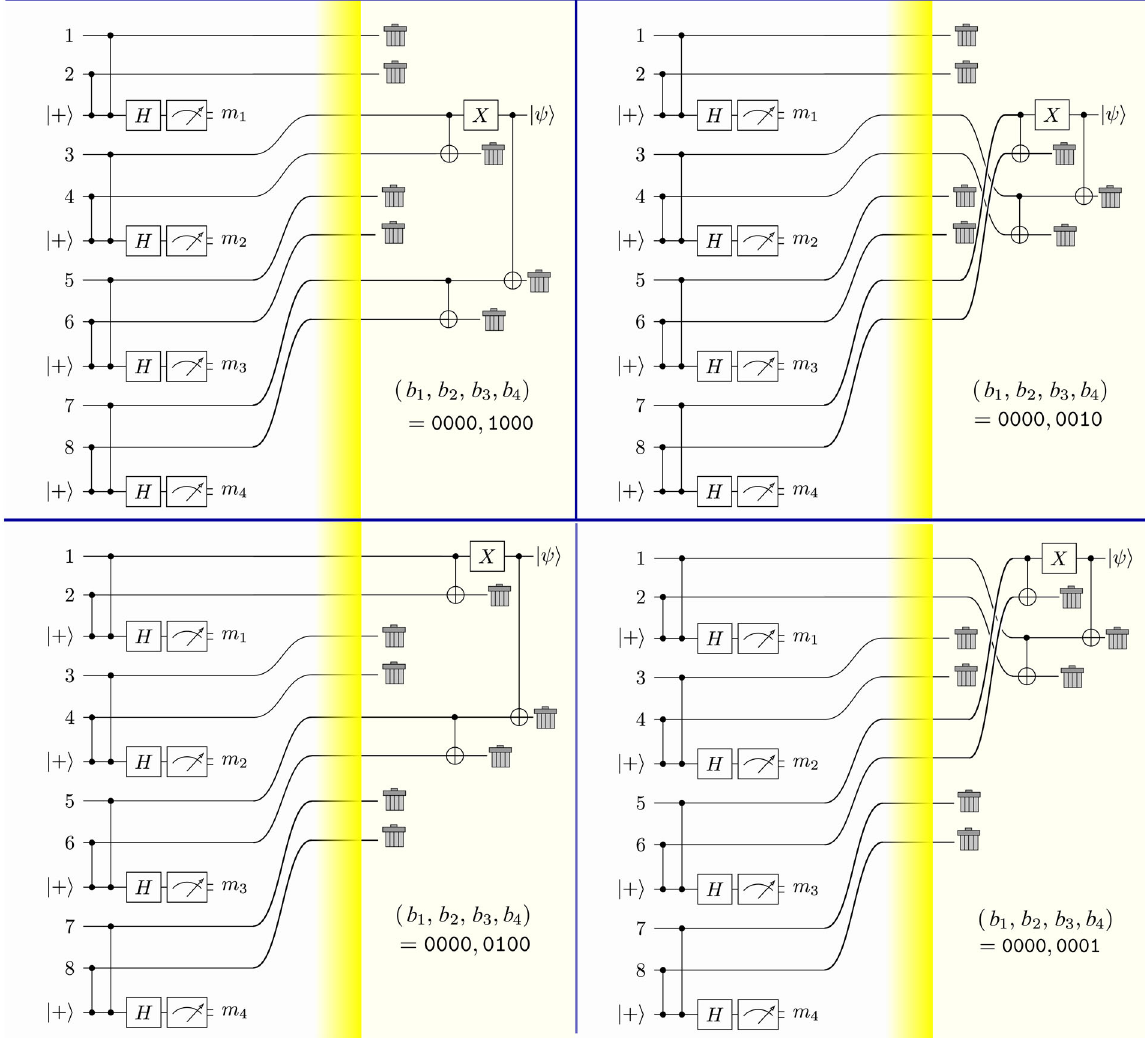
Fig. 4 Syndrome extraction and decoding of C 8 qubit . The syndrome vector is b = ( b 1 ; b 2 ; b 4 ; b 4 ) = (1 − ( m 1 ; m 2 ; m 3 ; m 4 ))/2. If the Hamming weight of the syndrome vector is one, we can still correctly decode the logical qubit. For this, we discard four qubits and subsequently employ the same decoding circuit up to a permutation. If the Hamming weight of b is 0, we can use any of the above decoding